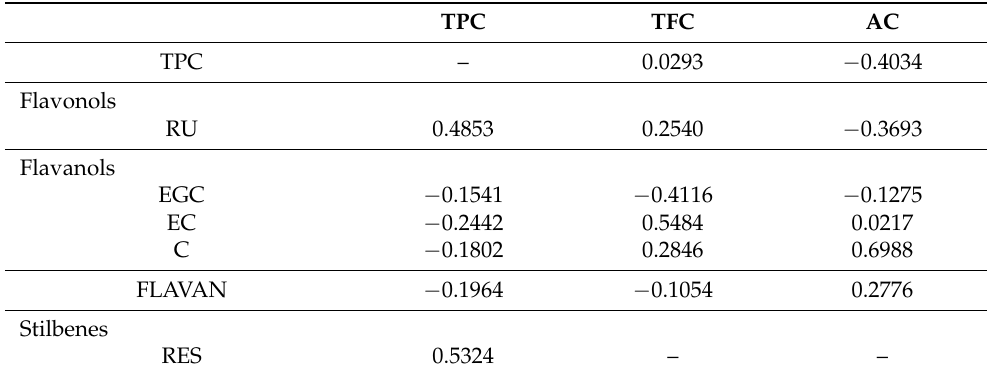
Table 6. Correlation coefficients (R) between total phenolic content (TPC), total flavonoid content (TFC), total anthocyanin content (AC) and individual phenolic compounds in the selected Sorbus cul- tivars. TPC TFC TPC – − 0.4034